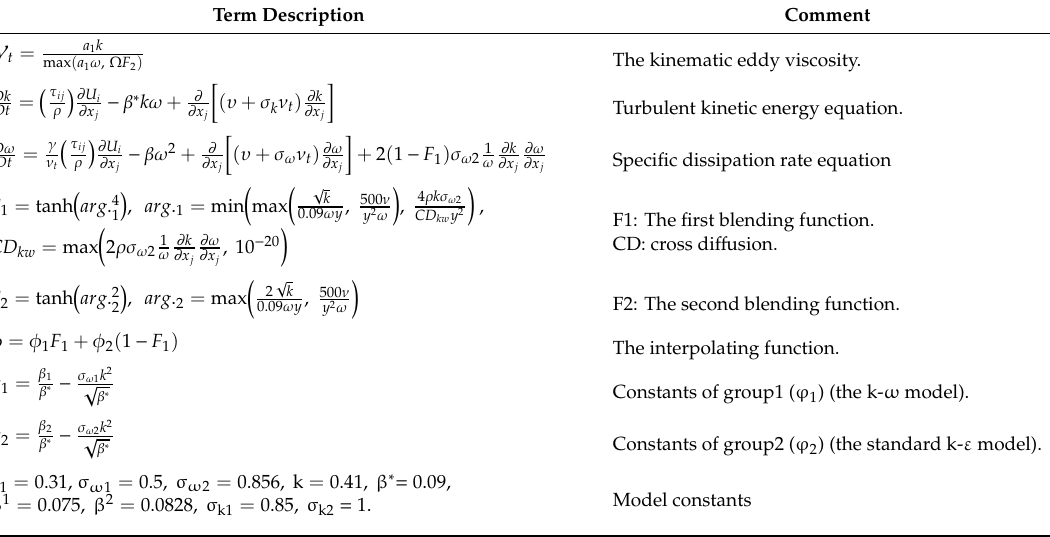
Table 5. Description of the SST k- ω model, Equations taken from Menter [39]. Term Description